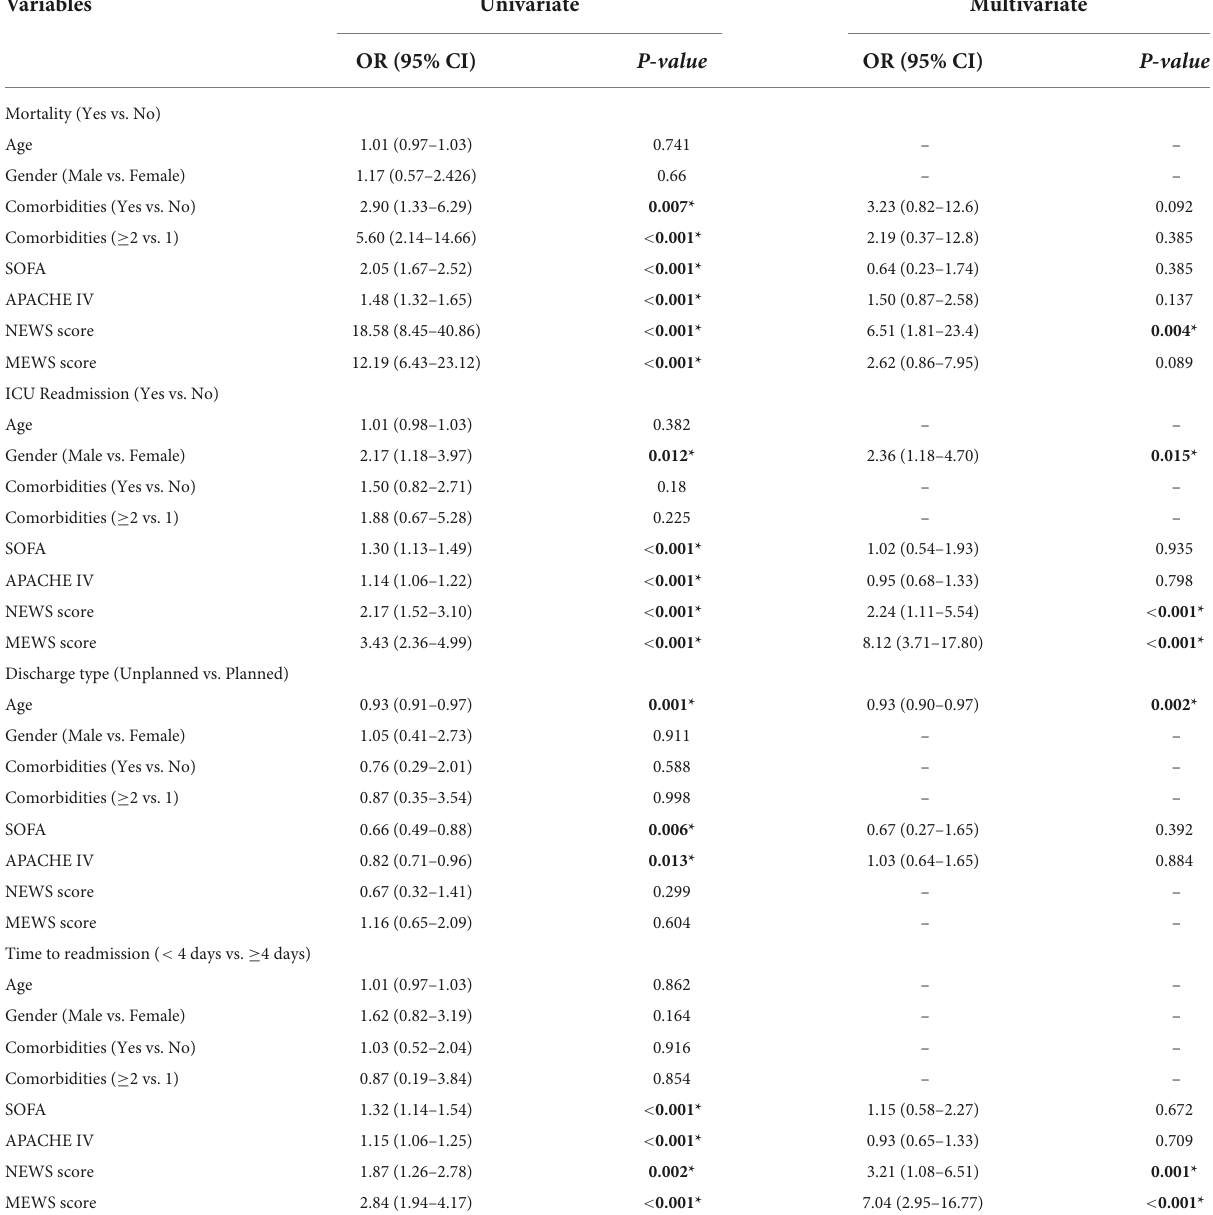
TABLE 4 Univariable and multivariable binary logistic regression analysis to evaluate associations of NEWS and MEWS scores to predict mortality, readmission, discharge type, and time to readmission. Variables Univariate Multivariate OR (95% CI) P-value OR (95% CI)